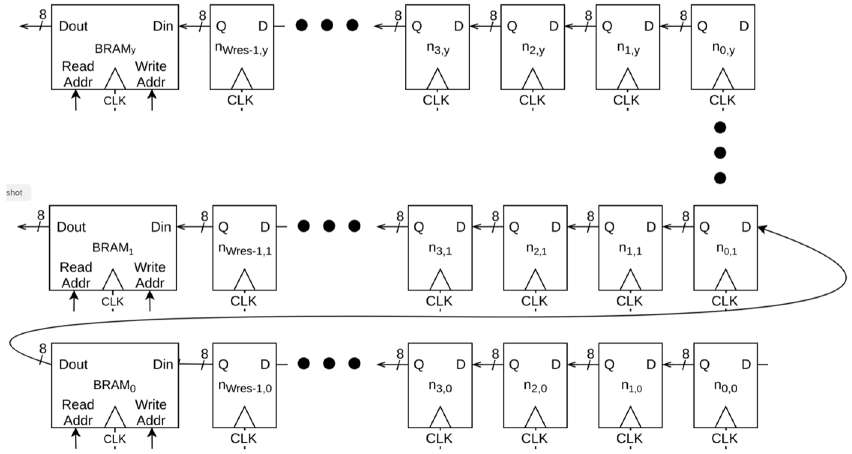
Figure 6. Using shift registers and BRAM as line buffers.